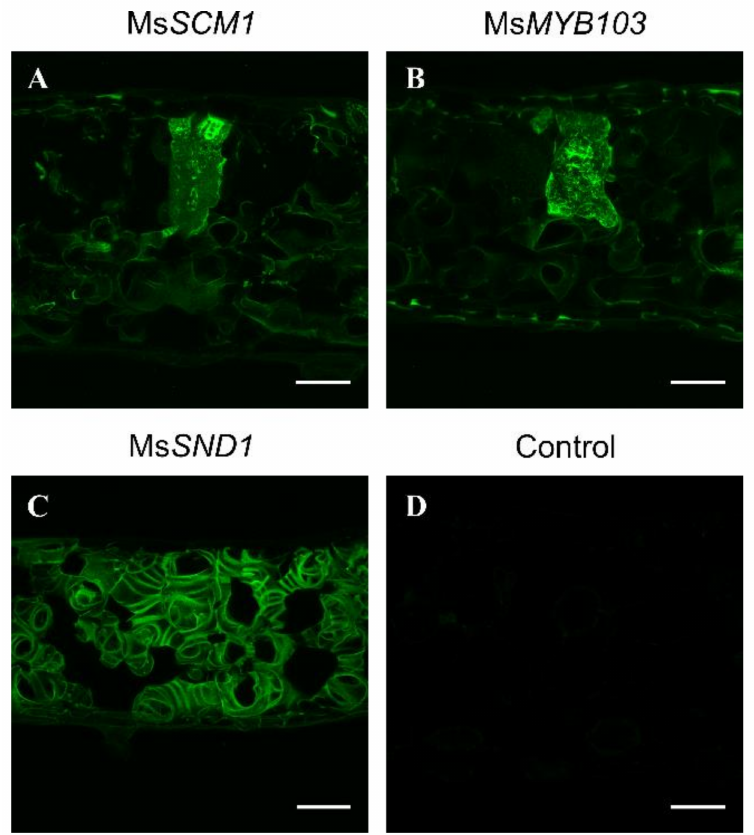
Figure 2. Lignin formation induced by ectopic expression of MsSCM1 ( A ), MsMYB103 ( B ), and MsSND1 ( C ) in N. benthamiana leaves. After 5 days of ectopic expression, leaf cross-sections were stained with Basic Fuchsin to observe fluorescence under a confocal microscope. Infiltration of the empty vector served as control ( D ). Scale bar—50 µ